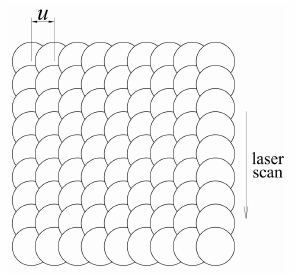
Figure 8. Defect-free cladding result.